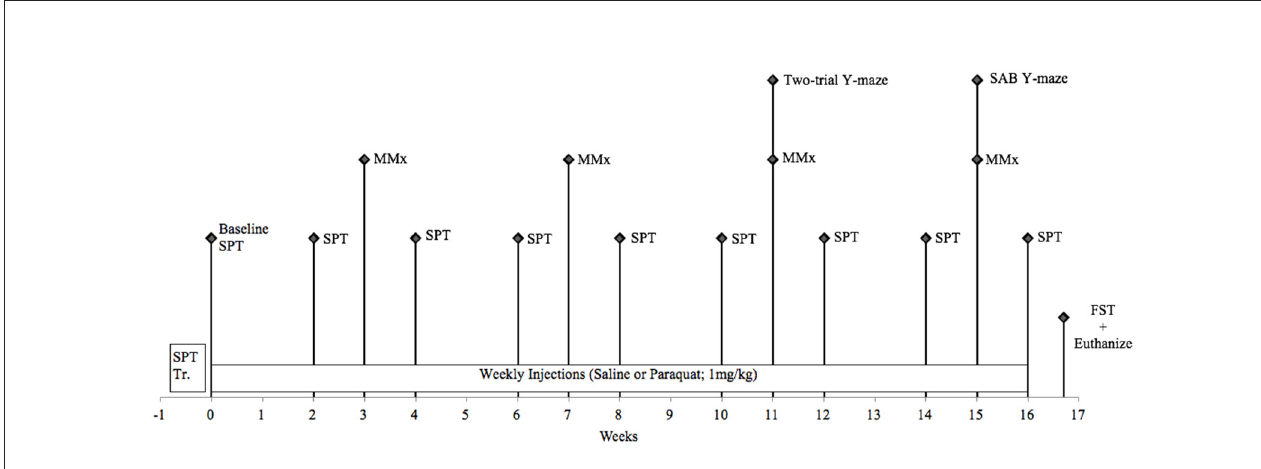
FIGURE 2 | Schematic timeline for study 2. FST, forced swim test; MMx, micromax; SAB, spontaneous alternation behavior; SPT, sucrose preference